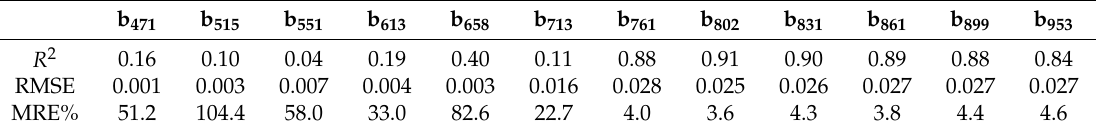
Table 3. R 2 , RMSE and MRE [%] for the relationships between the reflectance acquired by the 12 Mini-MCA bands and ground-based measurements at the 22 permanent observation sites.